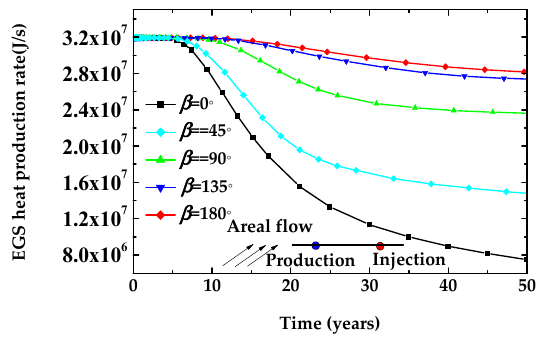
Figure 12. Heat generation rate of EGS changes with time.